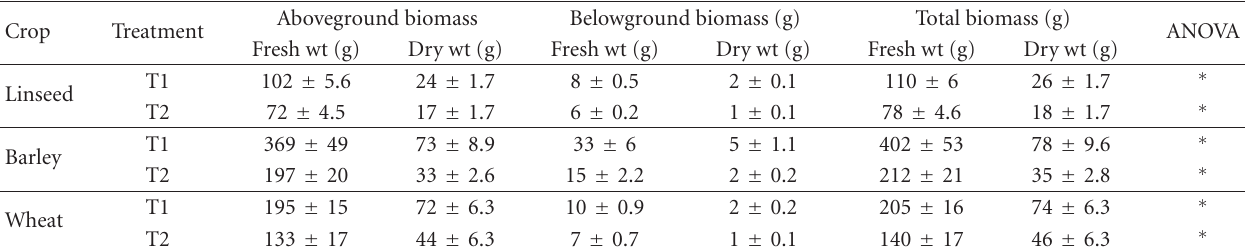
Table 4: Mean ( ± SEM) dry matter of plant organs (g seedling − 1 ). Linseed Barley Wheat Plant organ T1 T2 T1 Fruit 4 ±